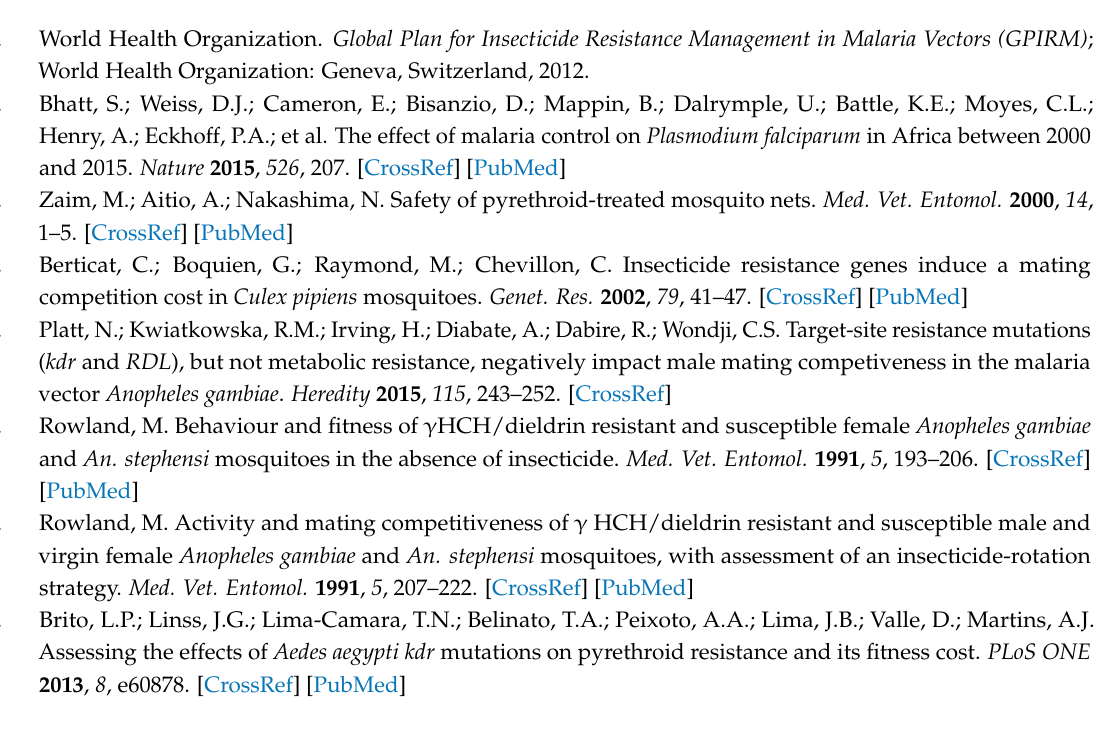
Table S1: Distribution of L119F-GSTe2 genotypes between oviposited and non-oviposited females; Table S2: Change in the distribution of L119F-GSTe2 genotypes and pupae